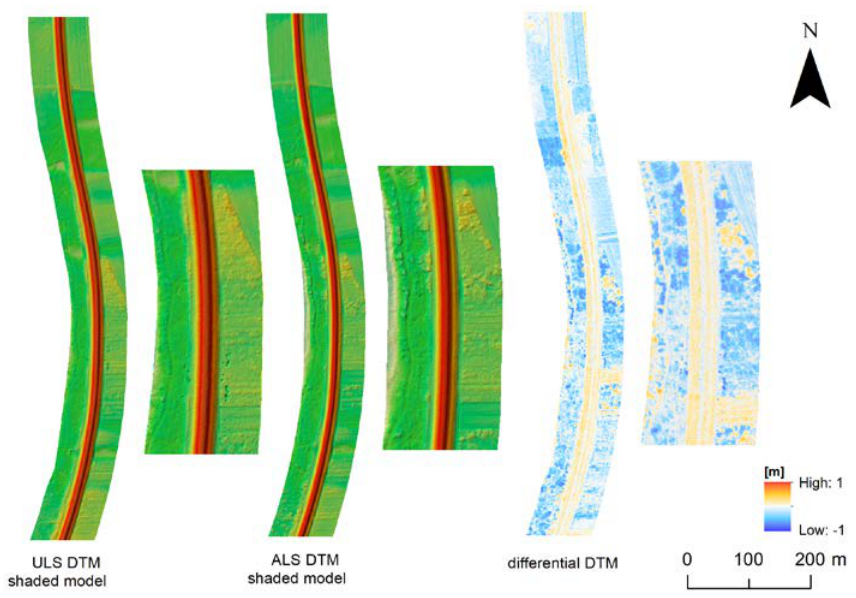
Figure 3. Digital terrain models generated from airborne laser scanning (ALS) and ULS data with the calculated differential model of elevation.